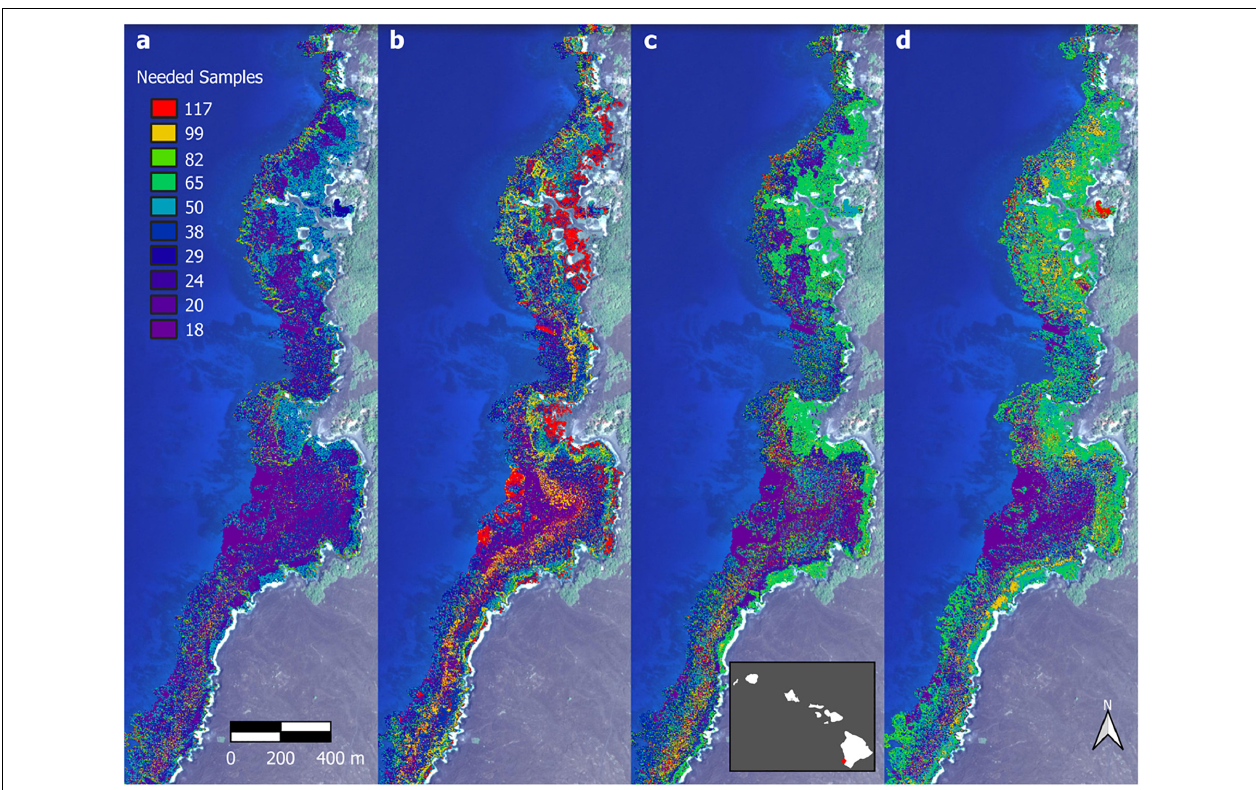
FIGURE 11 | Loss in mapped spatial structure of (a) total fish biomass, (b) scrapers, (c) browsers, and (d) grazers that results from a reduction in the number of field sites used in the upscaling process. Background imagery retrieved from Google, ©2021 Maxar